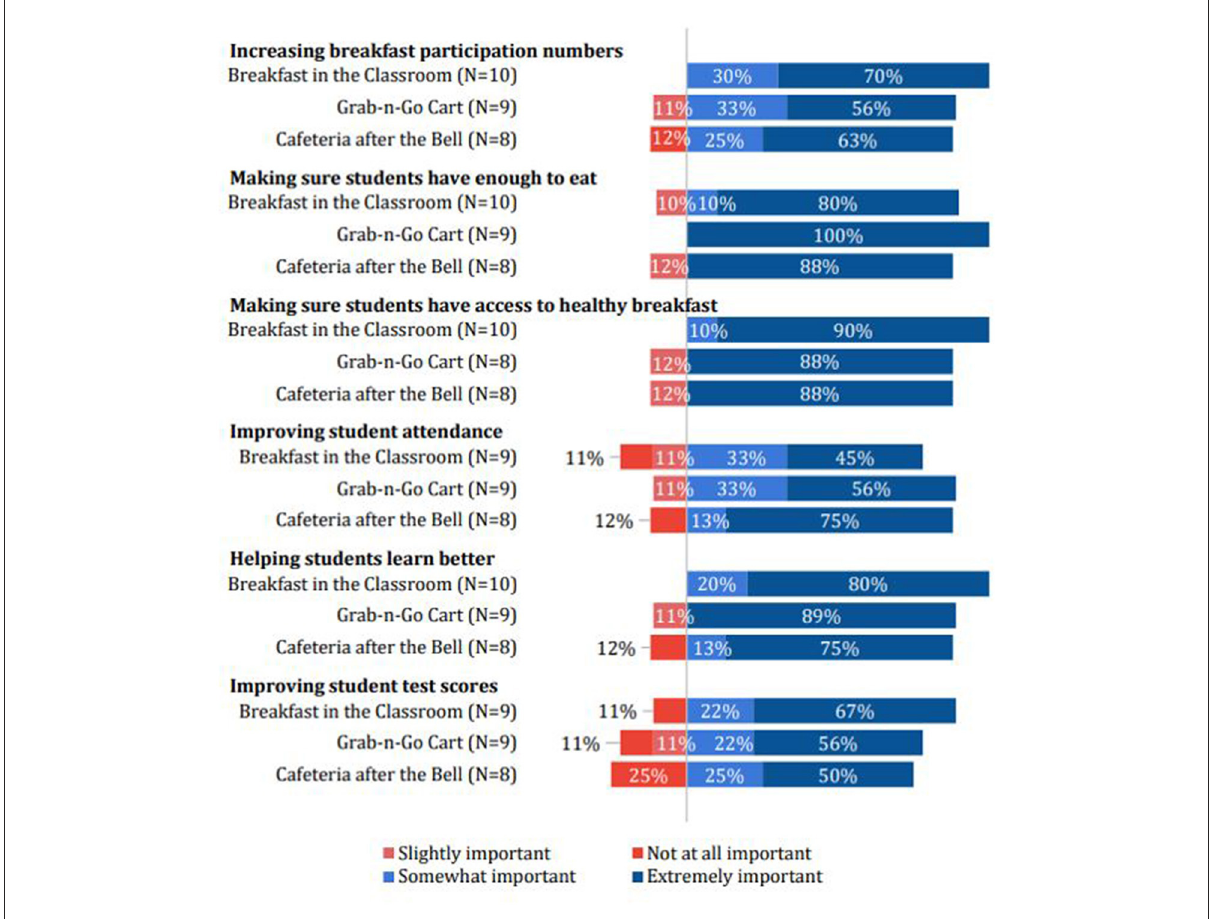
FIGURE1 Relative advantage of school breakfast model